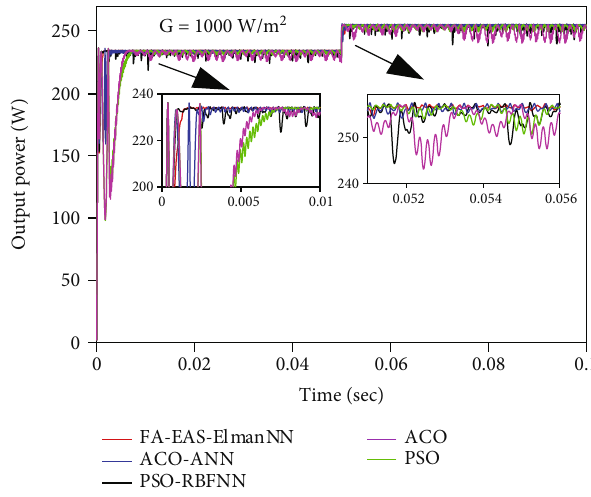
Figure 16: MPPT curve under rapidly changing T ( G = 1000 W/m 2